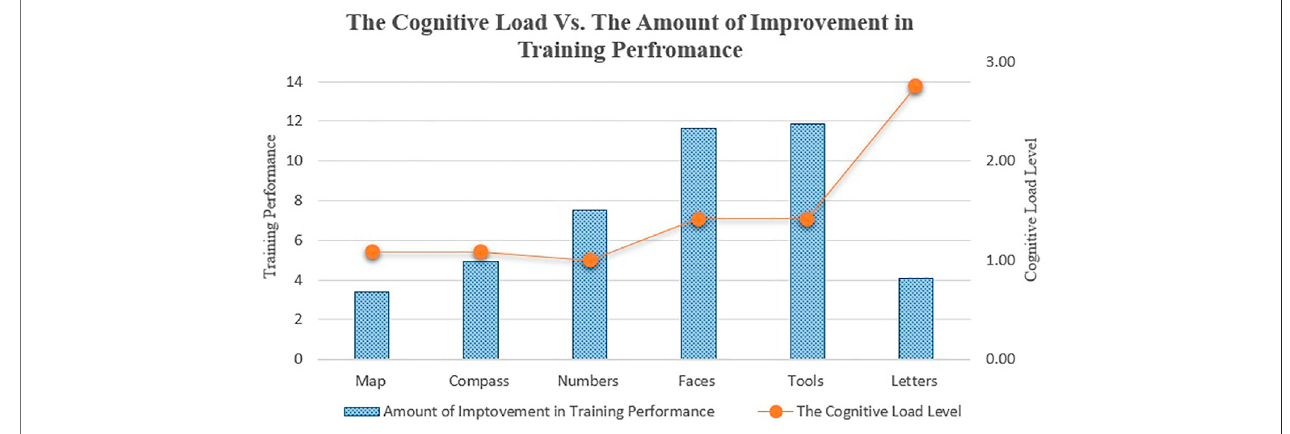
FIGURE 9 | Cognitive load level vs. the amount of improvement in children ’ s training performance. It compares between the induced cognitive load level by each activity and the amount of improvement in the children ’ s training performance (the difference between post- and pretraining performance) in each